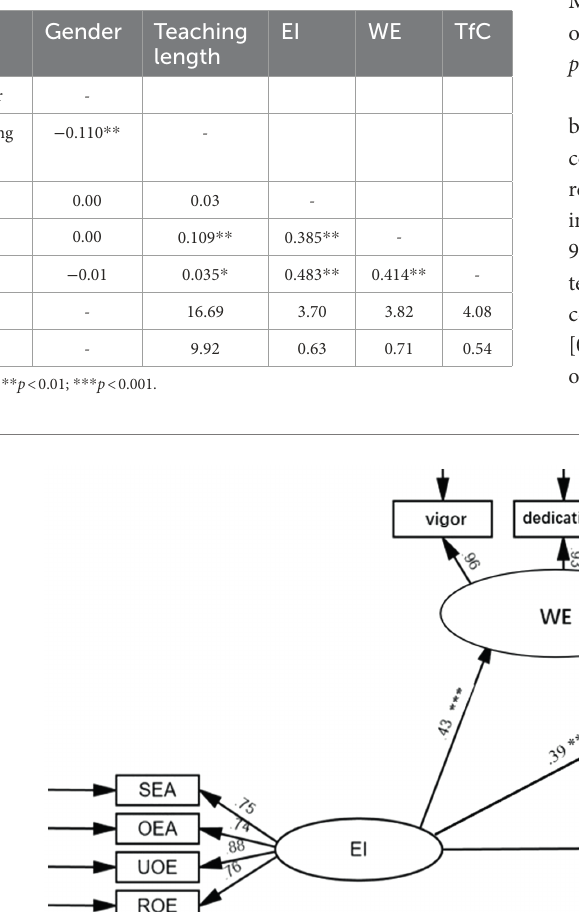
TABLE 1 Descriptive statistics and correlations between variables.